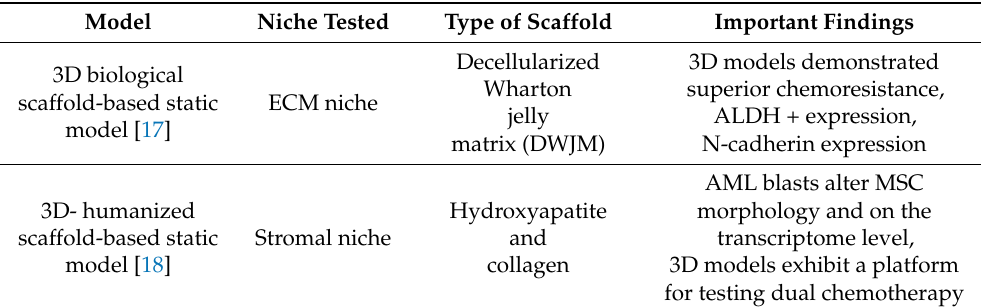
Table 2. Comparison between biologic scaffold-based 3D models. Model Niche Tested Type of Scaffold Important